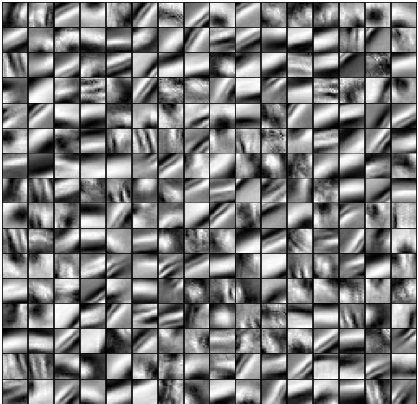
Figure 4. High-resolution image patch of high-frequency component trained with the area 0_0.